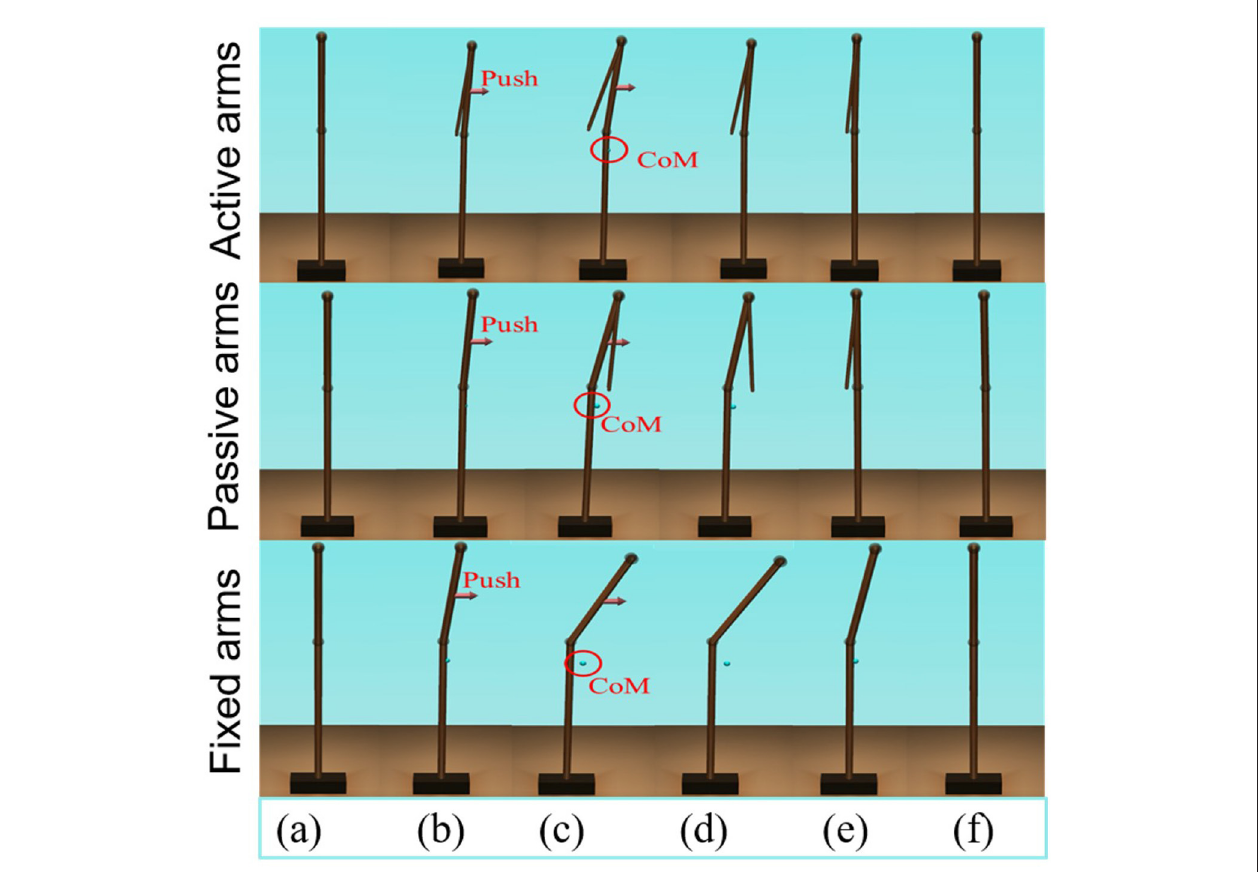
FIGURE 4 | Schematic of the balance behavior for the three different arm states (“top to bottom: active arms, passive arms, and fixed arms”), for a disturbing force of 70 [ N ]. (A,F) Represent the equilibrium states; (B) represents the pushing forward process; (C–E) represents the balance recovery behavior.